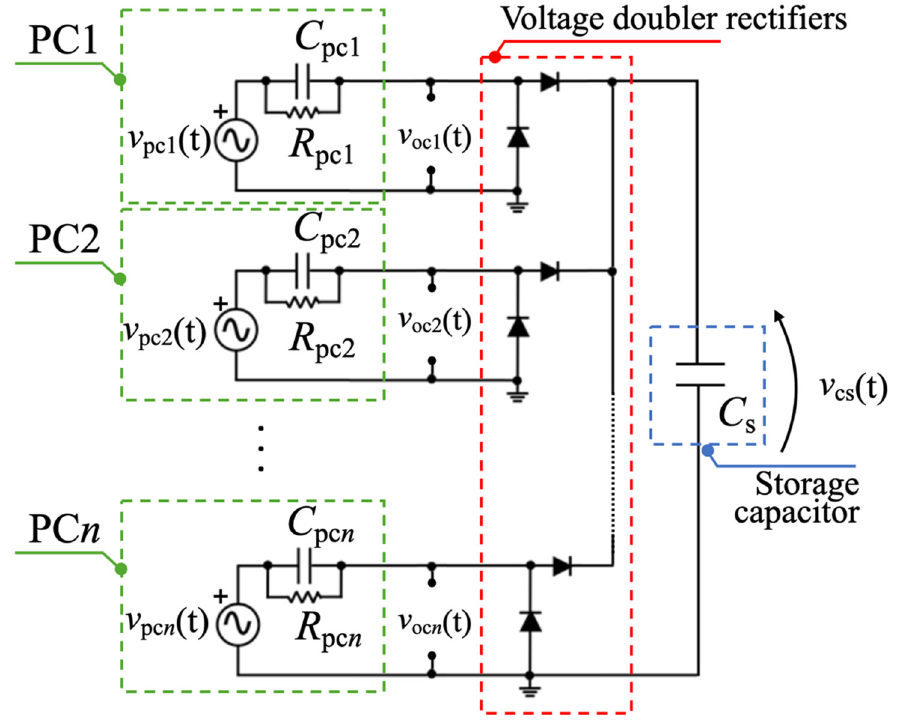
Figure 10. Passive parallel-like electrical configuration of a generic n-multi-converter piezoelectric harvester.